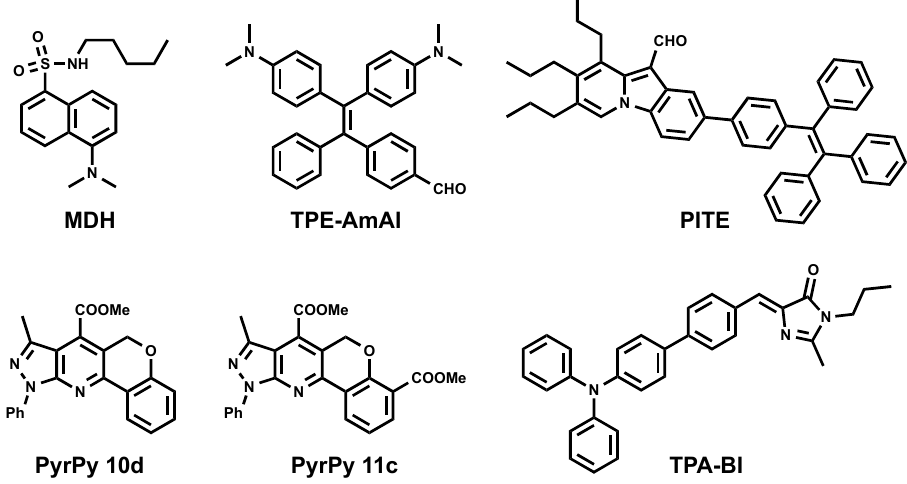
Figure 3. Chemical structures of blue emitting LD probes.